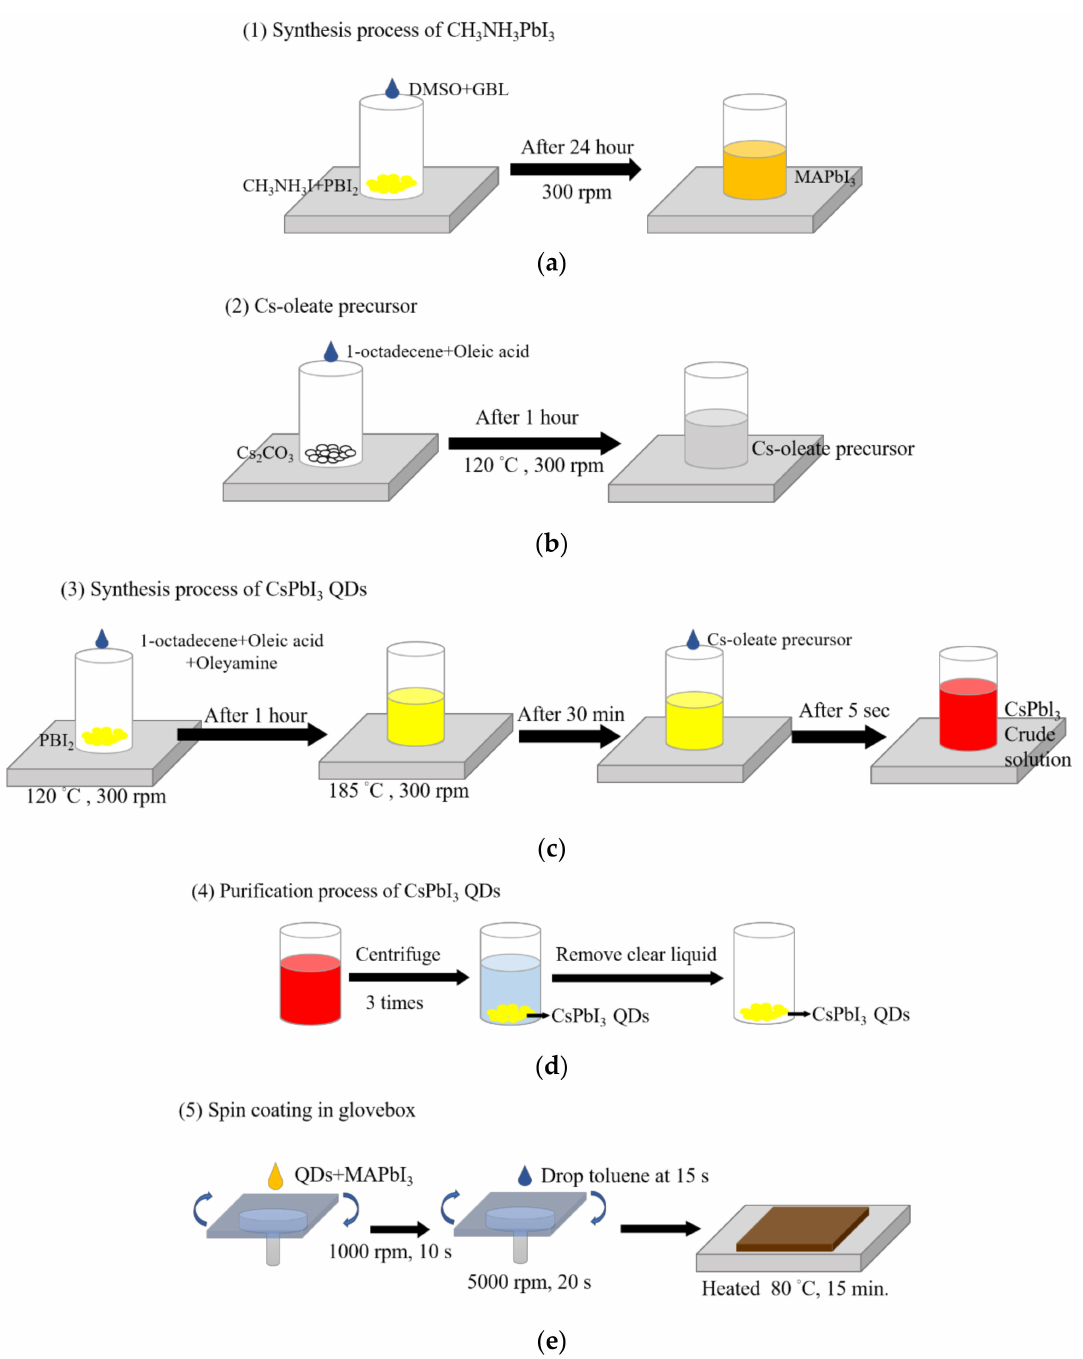
Figure 1. ( a – e ) Schematic diagram of perovskite, perovskite quantum dots, and fabrication of thin